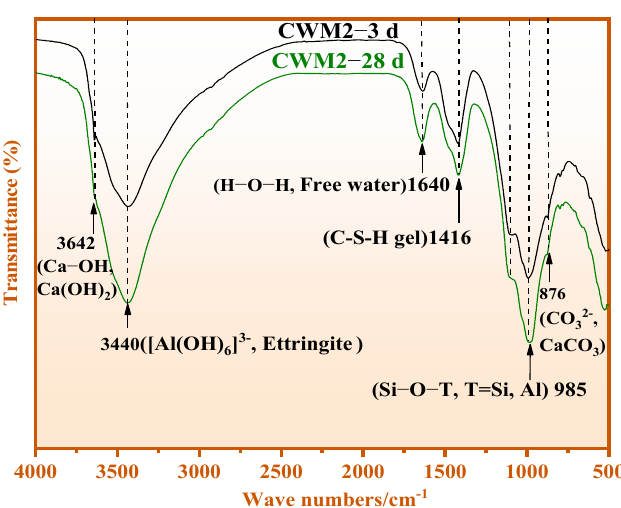
Figure 10. FTIR results of CWM2-3 d and CWM2-28 d.